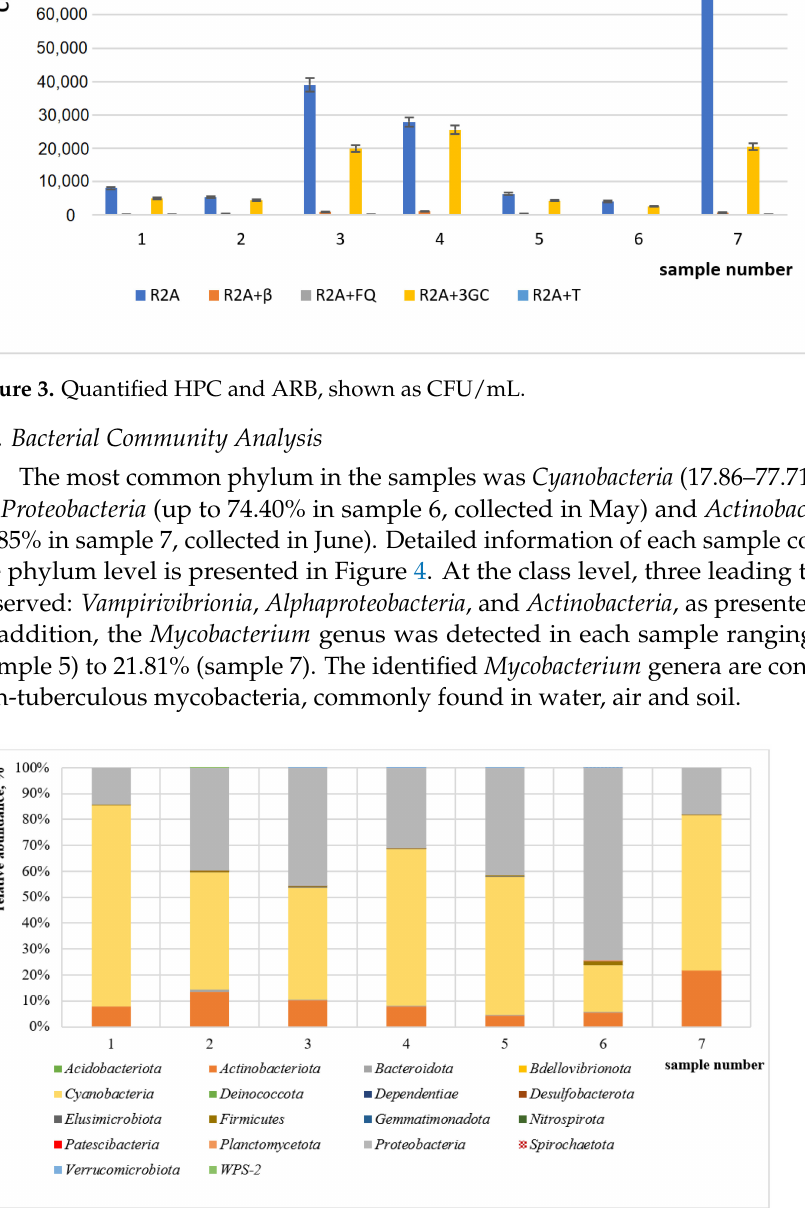
Figure 4. Bacterial communities in all samples at the phylum